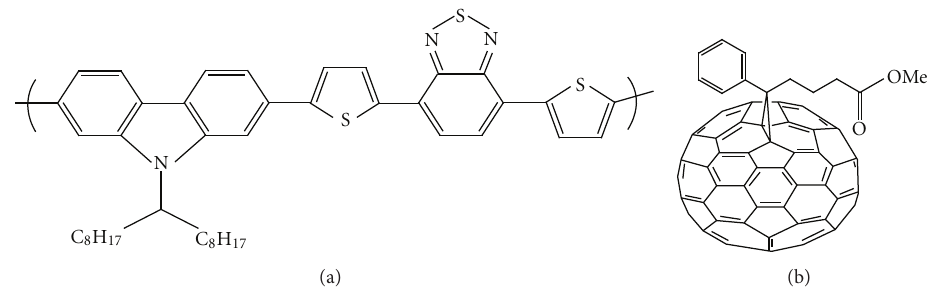
F 1: Molecular structure of (a) PCDTBT and (b) PC